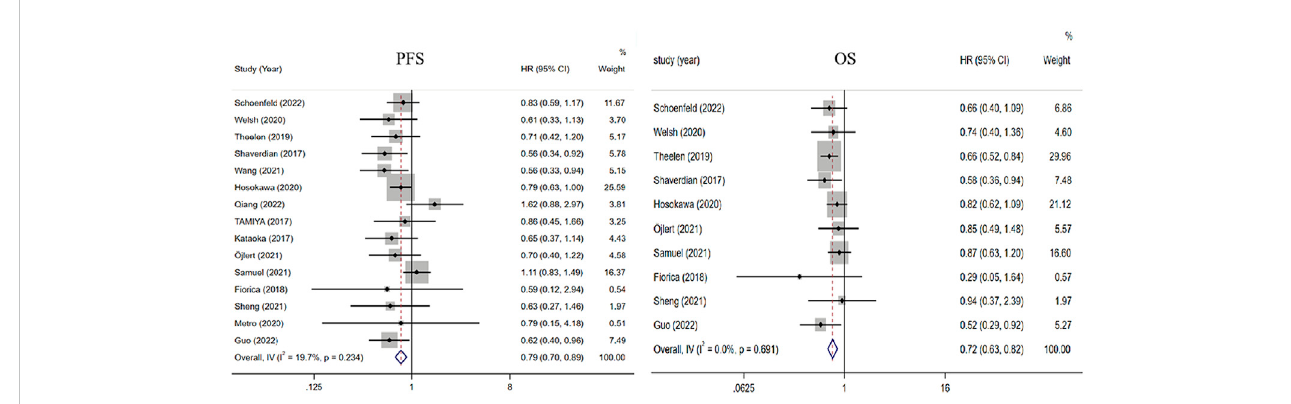
FIGURE 2 Forest plot of thesurvival bene fi tsassociated with RTcombined with ICIs and ICIs alone. In terms of PFS and OS, the HRs of RT combined with ICIs were 0.79 (0.70, 0.89) and 0.72 (0.63, 0.82), respectively. Abbreviations: RT, radiotherapy; ICIs, immune checkpoint inhibitors; PFS, progression-free survival; OS, overall survival; HR, Hazard ratio.